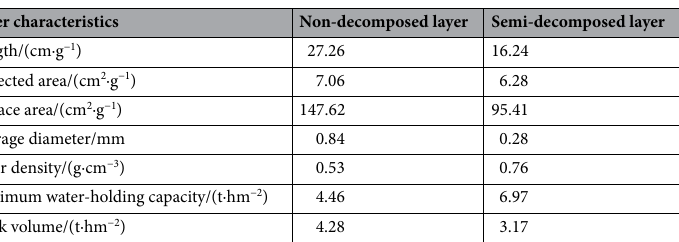
Table 1. Characteristics of the non-decomposed and semi-decomposed layers of Pinus massoniana litter. Litter characteristics were determined by Win RHIZO Pro 2.0 image analysis software, and litter density measured by a volumetric drainage method.